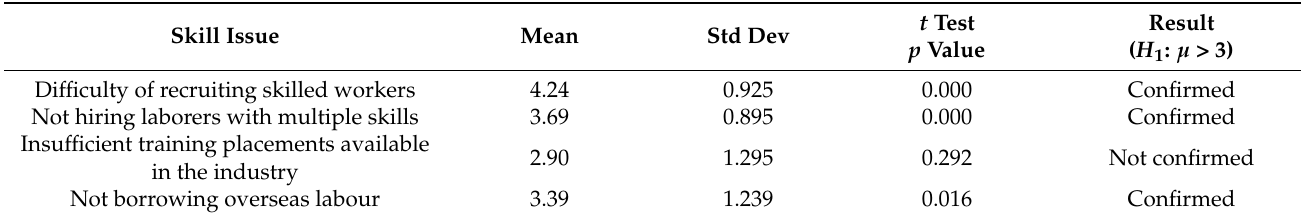
Table 3. Mean comparison of skill issues in the prefabricated construction industry.